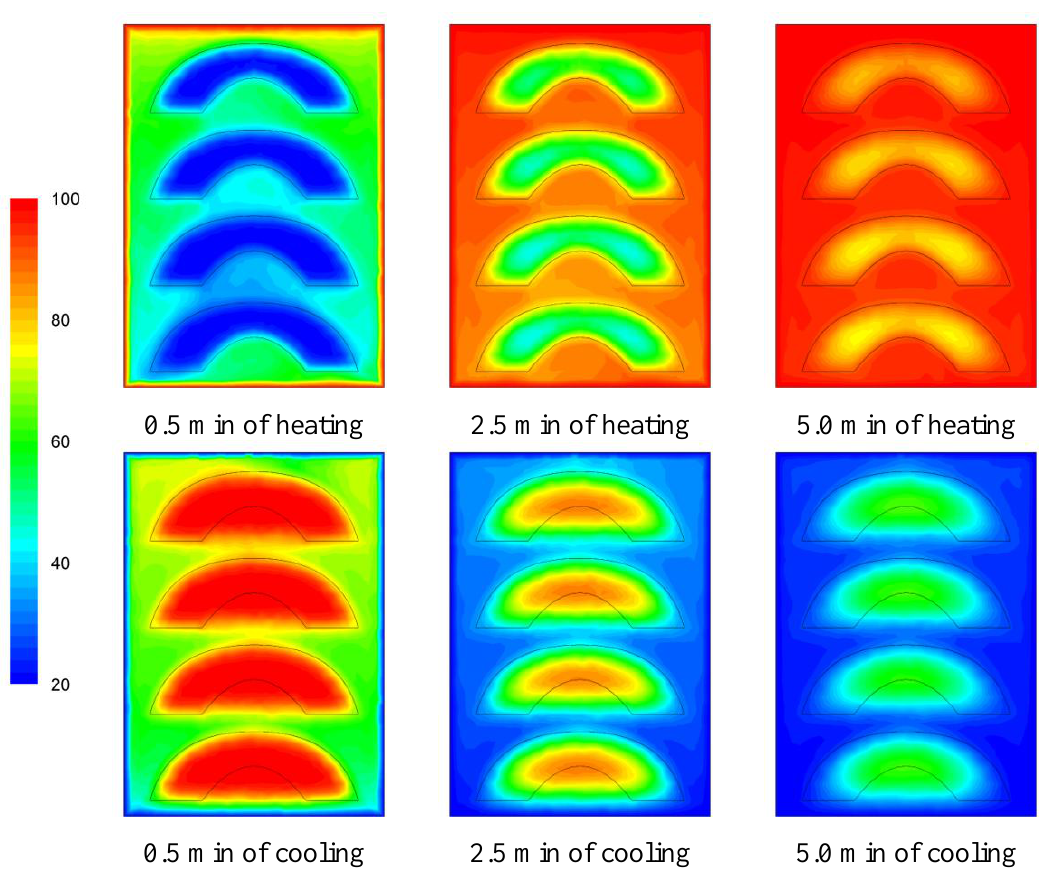
Figure 7. Temperature (°C) contours for peach halves in syrup at different heating and cooling times during heating (at 100 °C) and cooling (at 20 °C) for the “downward” case.